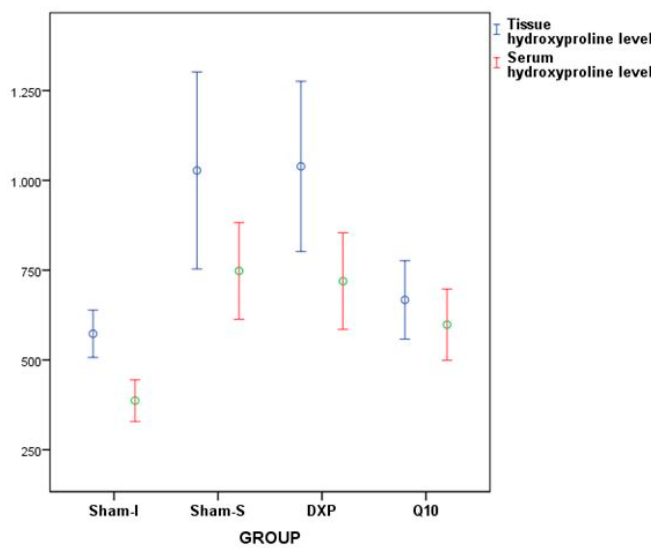
Figure 6. Error bars represent the tissue and serum hydroxyproline level values of all groups.